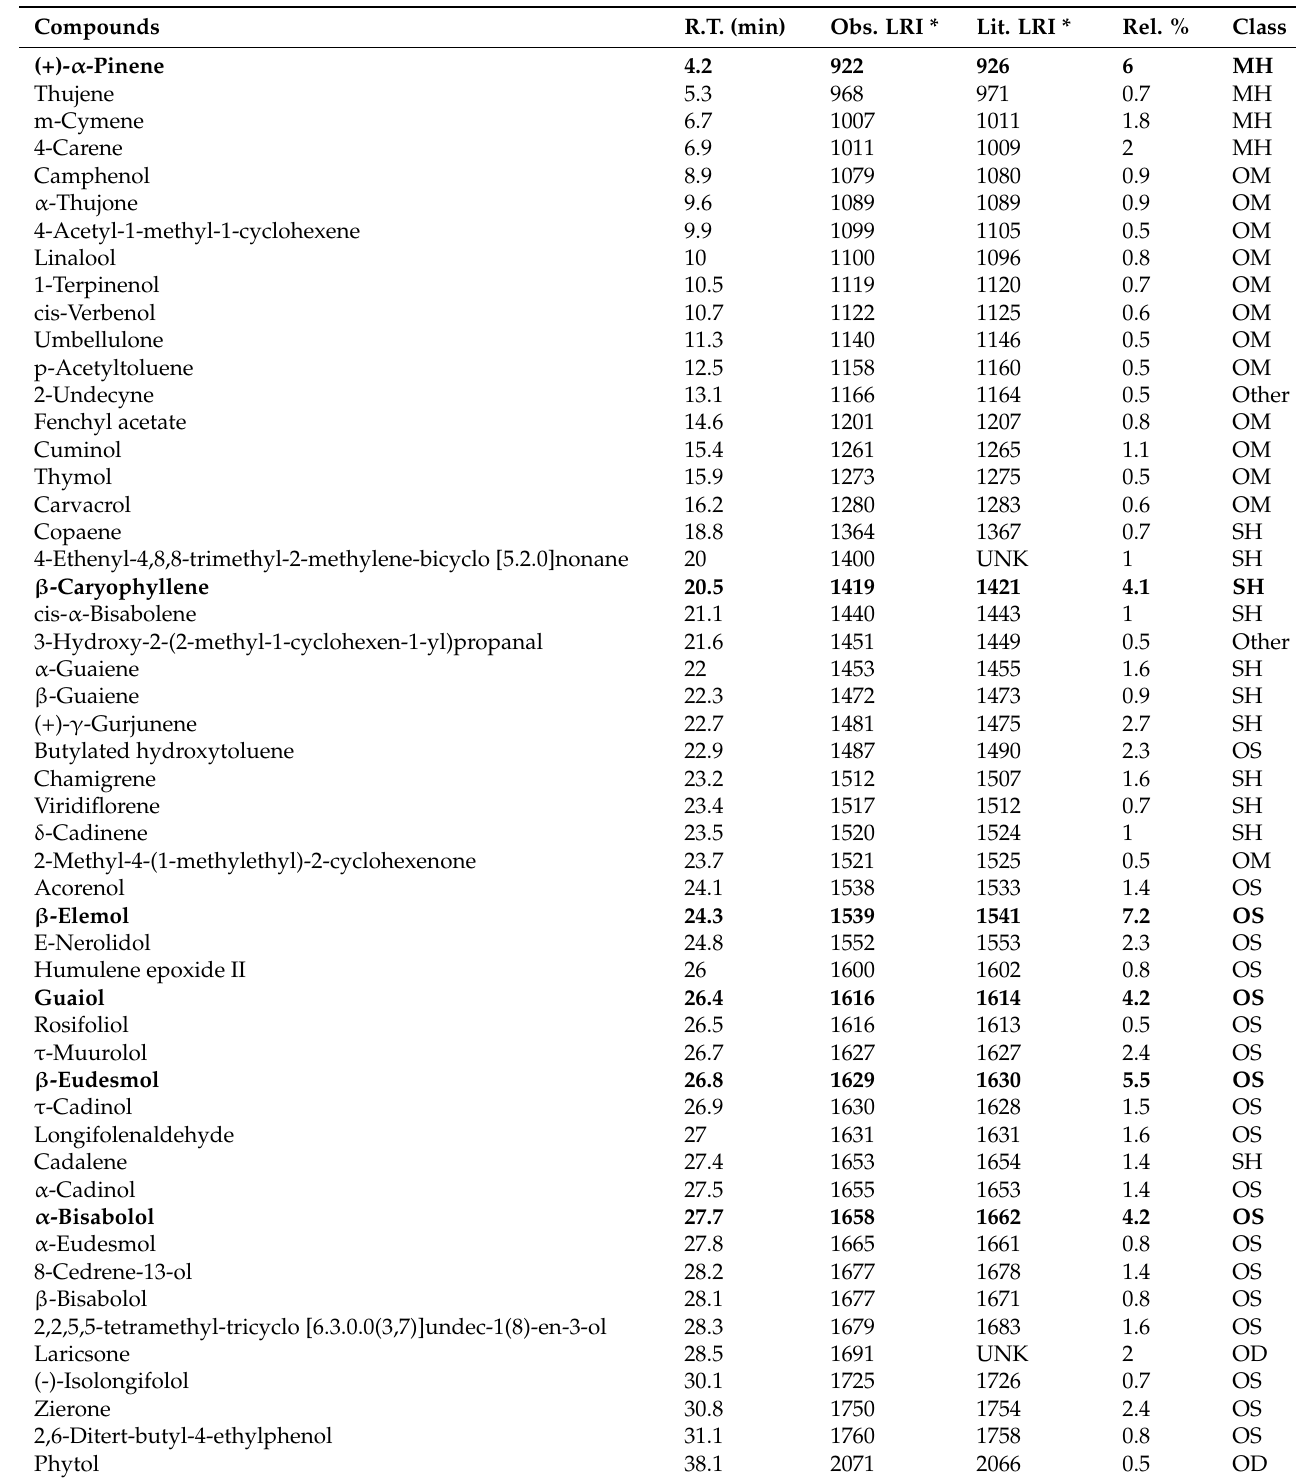
Table 1. Volatile compounds identified in the essential oil from the aerial parts of Teucrium luteum subsp. flavovirens growing wild in Tunisia. The most abundant constituents are reported in bold, and their structures are shown in Figure